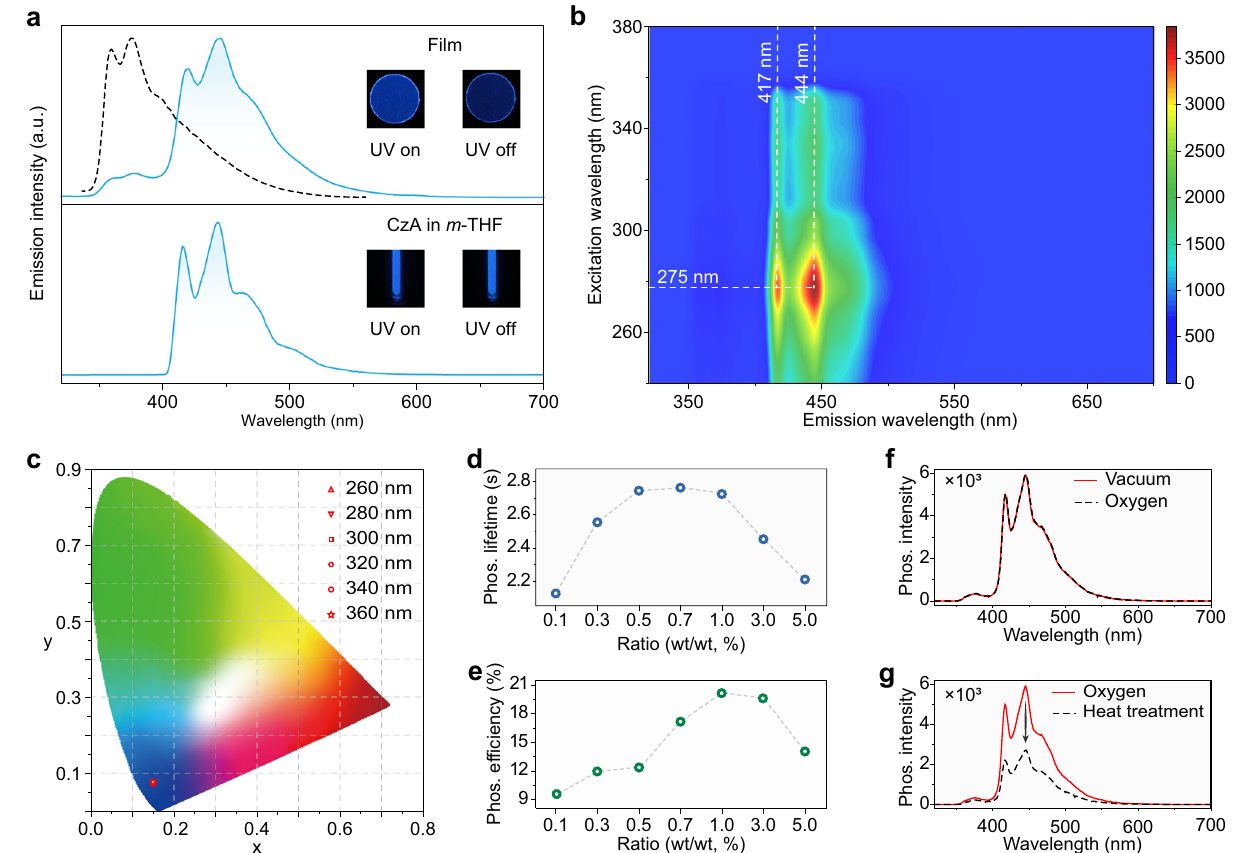
Fig. 2 | Photophysical properties of CzA in PVA fi lm and dilute solution. a Normalized steady-state photoluminescence (dash line) and phosphorescence spectra (solid lines) of CzA in PVA fi lm under ambient conditions (top) and in m - THFsolution(1×10 − 5 M)at77K(bottom).Inset:theleftisphotographstakenunder 302nm excitation, while the right is photographs of UOP after the removal of ultraviolet source. b Excitation-phosphorescence mapping of the CzA/PVA fi lm treatment (333K) in oxygen for